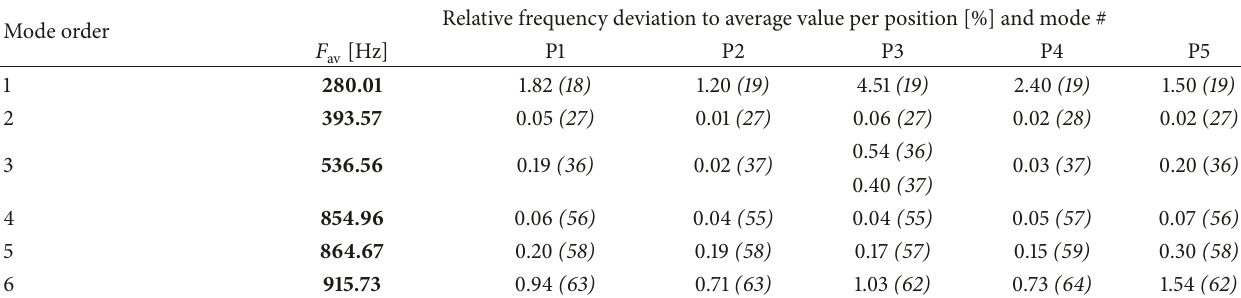
Table 4: Vibration modes almost exclusively related to contributions of the primary circuit